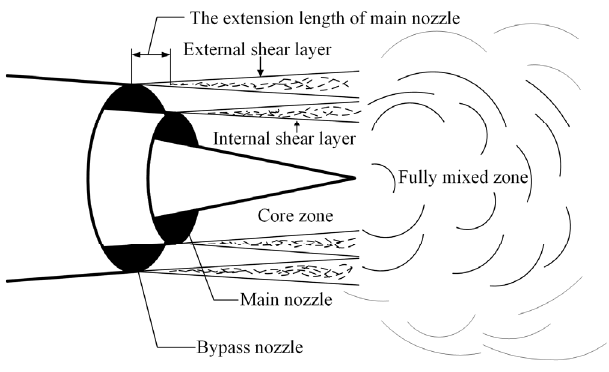
Figure 1. The structure of jet flow of turbofan engines with separate